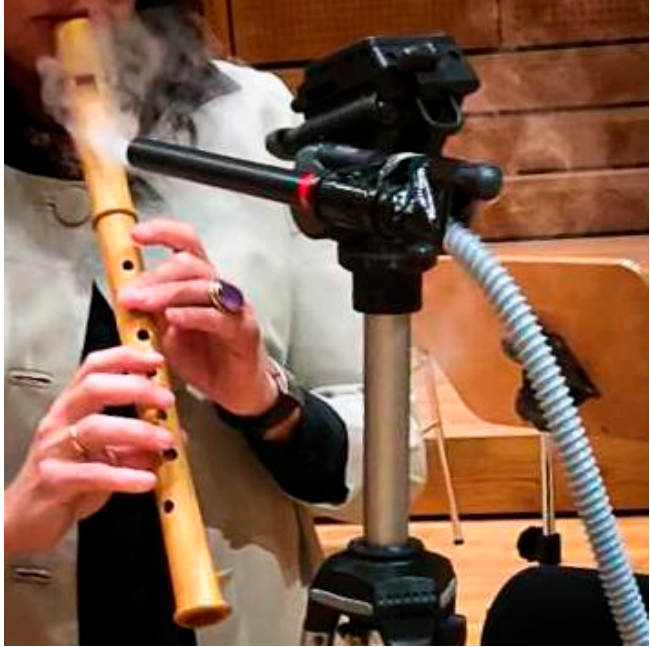
Figure A9. Artificial fog at the labium of the recorder.